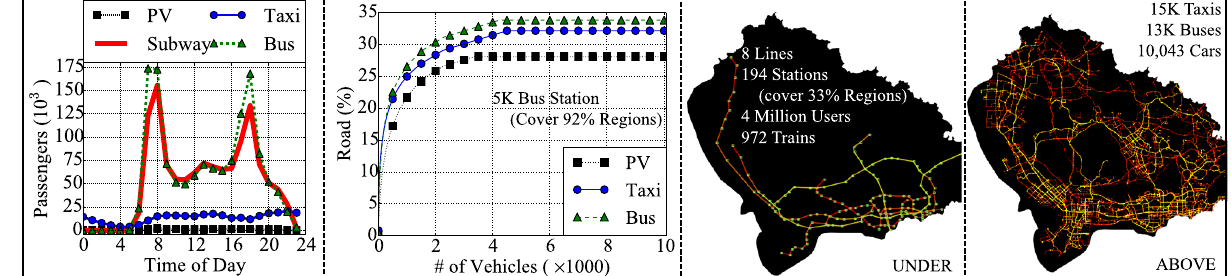
Figure 12. Mobility dataset in Shenzhen.